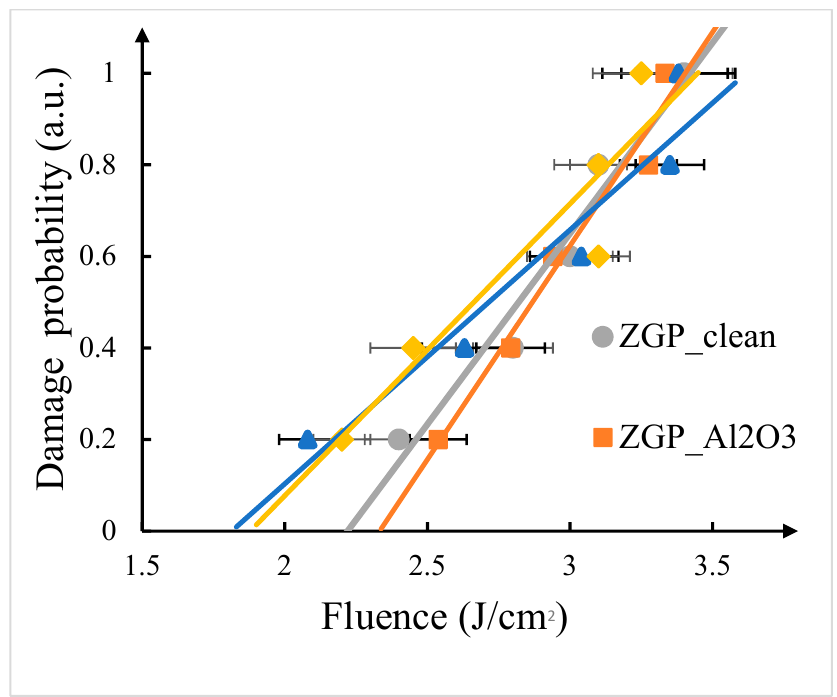
Figure 7. Dependence of the optical breakdown probability of samples ZGP_clean, ZGP_Al 2 O 3 and ZGP_1_ SiO 2 , ZGP_2_SiO 2 on the energy density of the incident laser radiation.